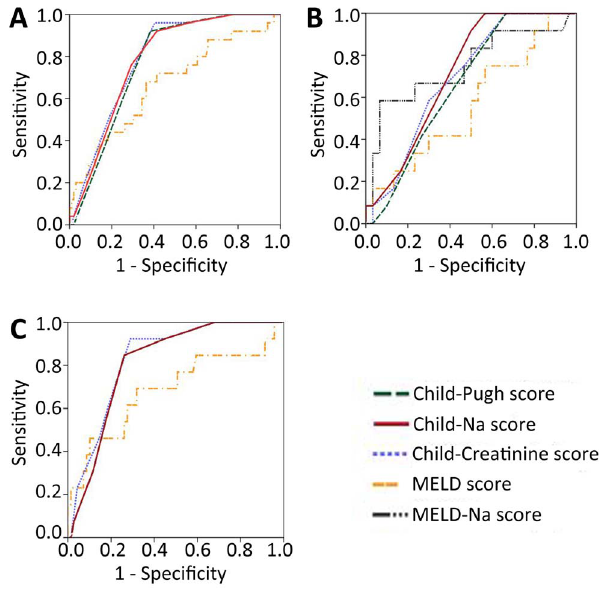
Figure 1. Comparison of the predictive values of the Child-Na, Child-Creatinine, Child-Pugh, MELD, and MELD-Na scores for one-year survival for all patients (A), for patients with serum Na levels , 138 mmol/L (B), and for patients with serum Na levels $ 138 mmol/L (C). Note : The MELD-Na score was not calculated in A and C because this model requires a serum Na concentration between 125 and 140 mmol/L.